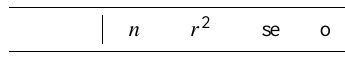
Table 4. Sigmoid profiles: relationship between log 10 -transformed depth-dependent shape parameter and log 10 -transformed Chl- a and Z e . n , r 2 , se and o are the number of points, the coefficients of de- termination, the residuals standard error and the order of the poly- nomial fit, respectively.